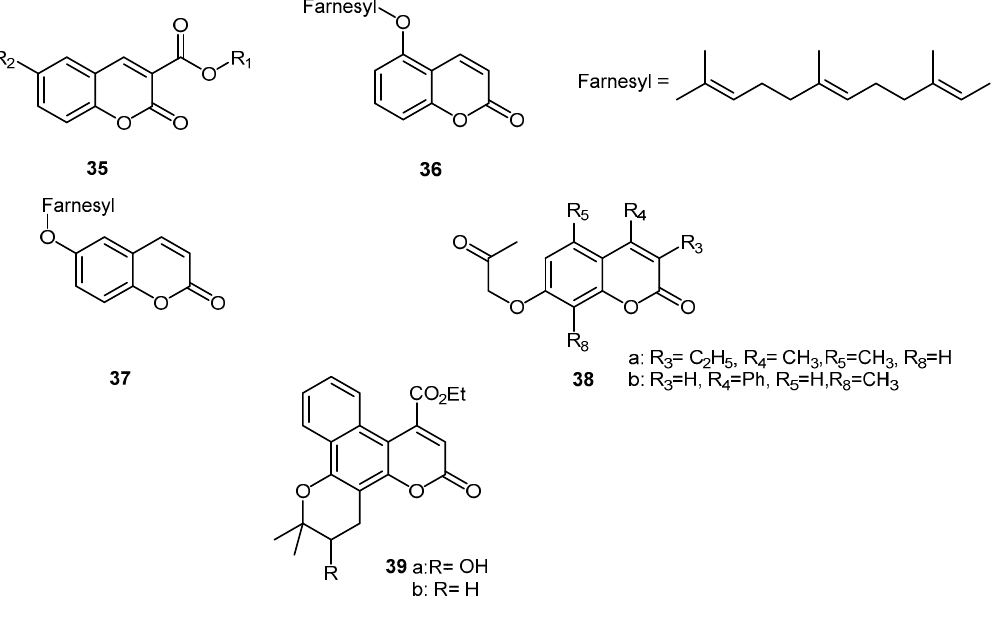
Figure 4. Synthetic coumarins and Figure 5. Synthetic coumarins and derivatives. Figure 4. Synthesis of paracetamol modified coumarins.